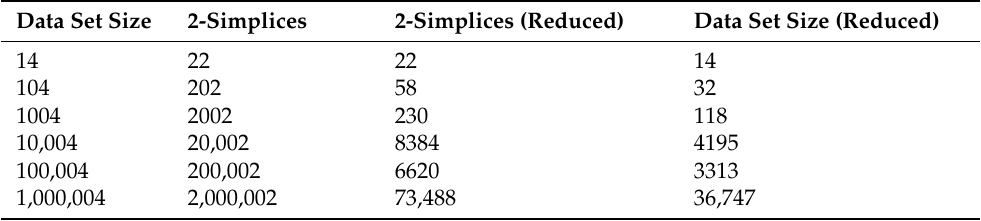
Table 2. The size of the two-dimensional synthetic data sets used, the number of 2-simplices obtained after computing the Delaunay triangulations, and the ones obtained after applying Algorithm 1. Data Set Size